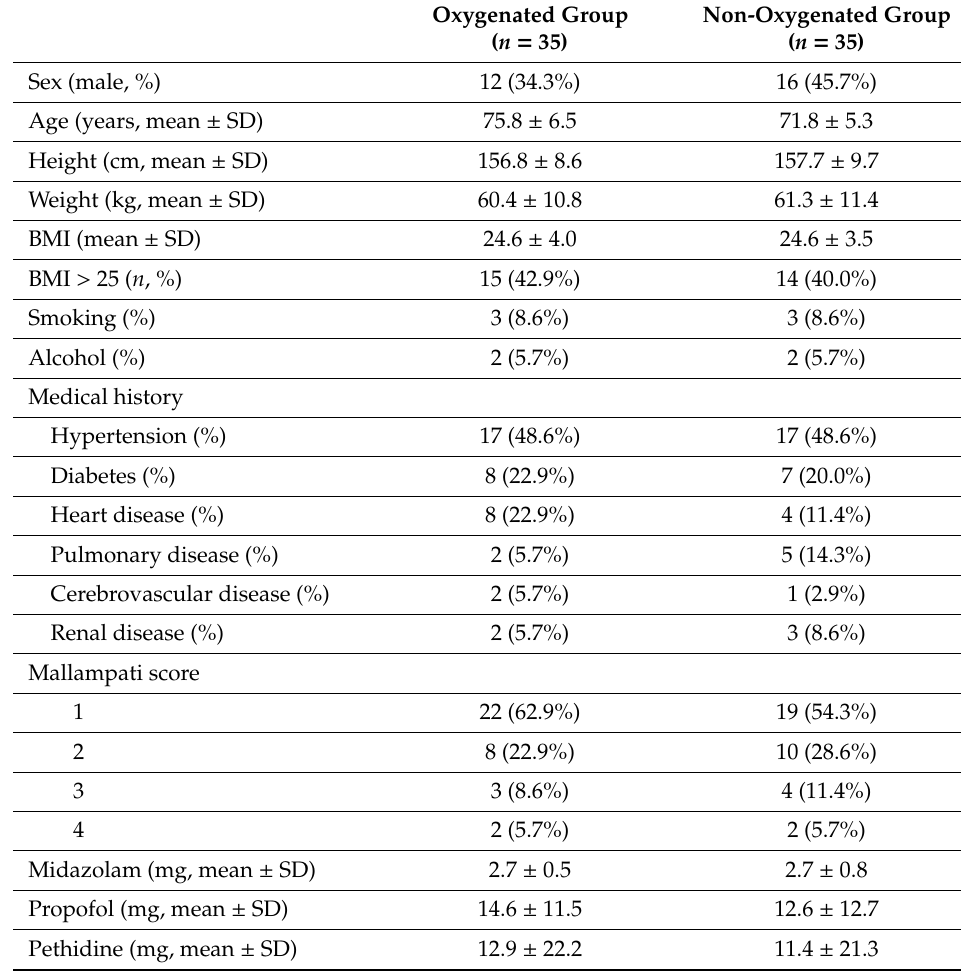
Table 1. Patients’ baseline characteristics in both groups.